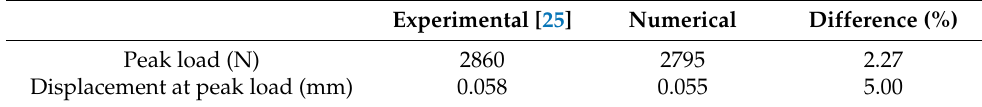
Table 3. Computational model and experimental test outcomes for masonry prism.